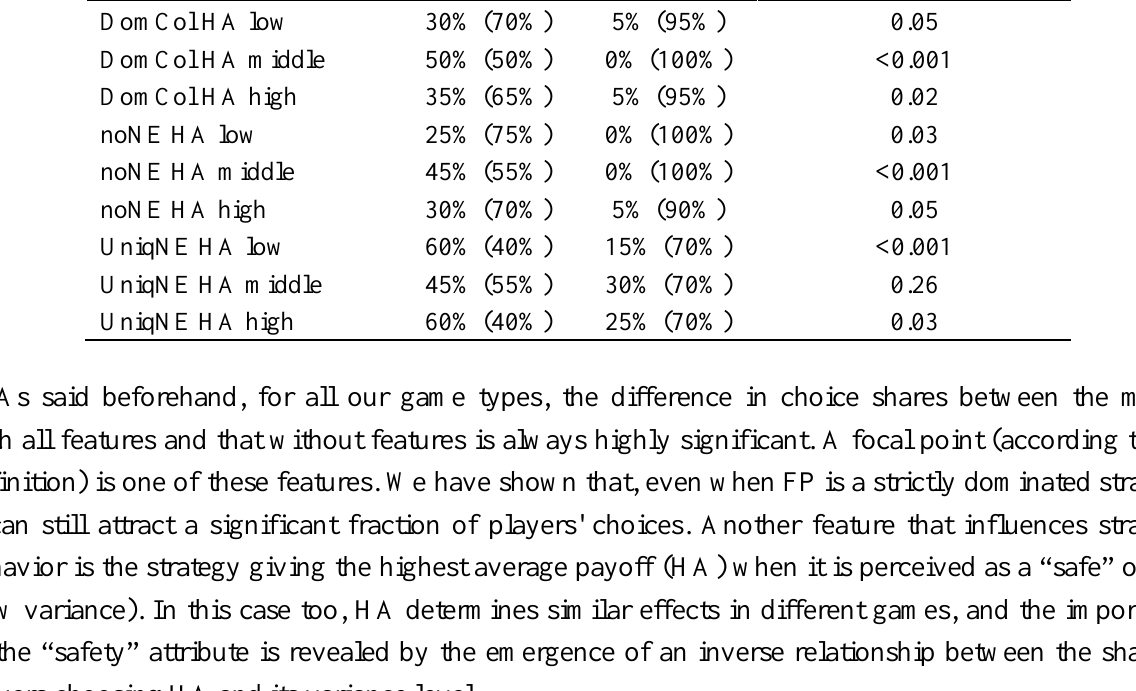
Table 4. Frequencies of FP and XFP choices for column players, and corresponding p - values. In brackets, choice frequencies of EQ and QES strategies in the corresponding matrices. FP (EQ) XFP (EQ) Binomial test one-tailed DomCol HA